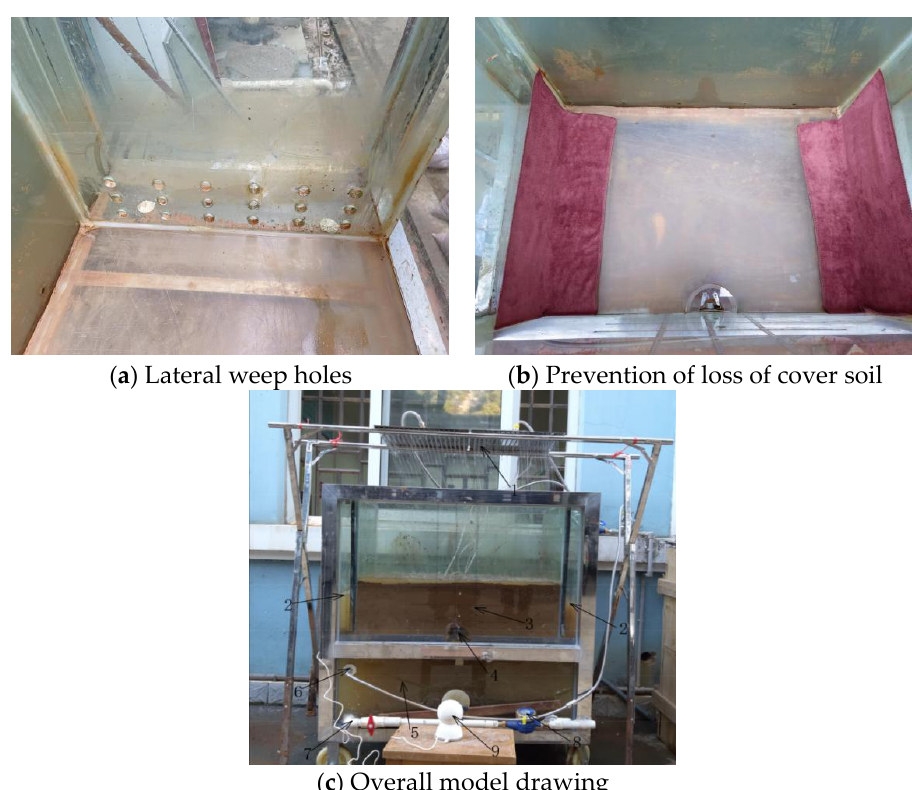
Figure 3. Physical model installations. 1—Special rainfall shower 2—model unit side water tank. 3—overburden soil 4—existing earth cave. 5—dissolving chamber water tank 6—dissolution chamber inlet. 7—dissolution chamber drain 8—drainage monitoring water meters. 9—cameras.